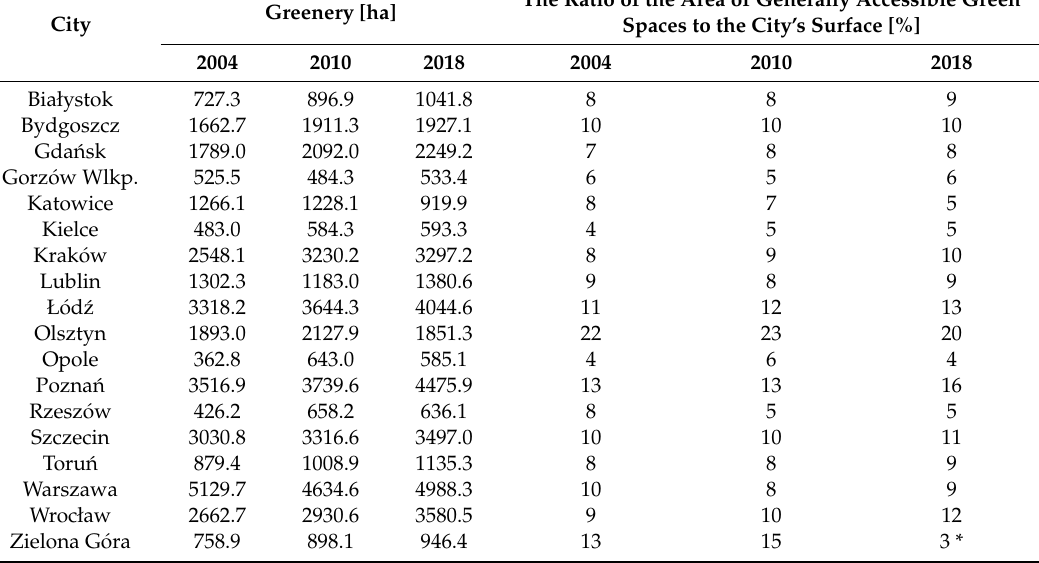
Warszawa 5129.7 4634.6 Wrocław 2662.7 Zielona G ó ra